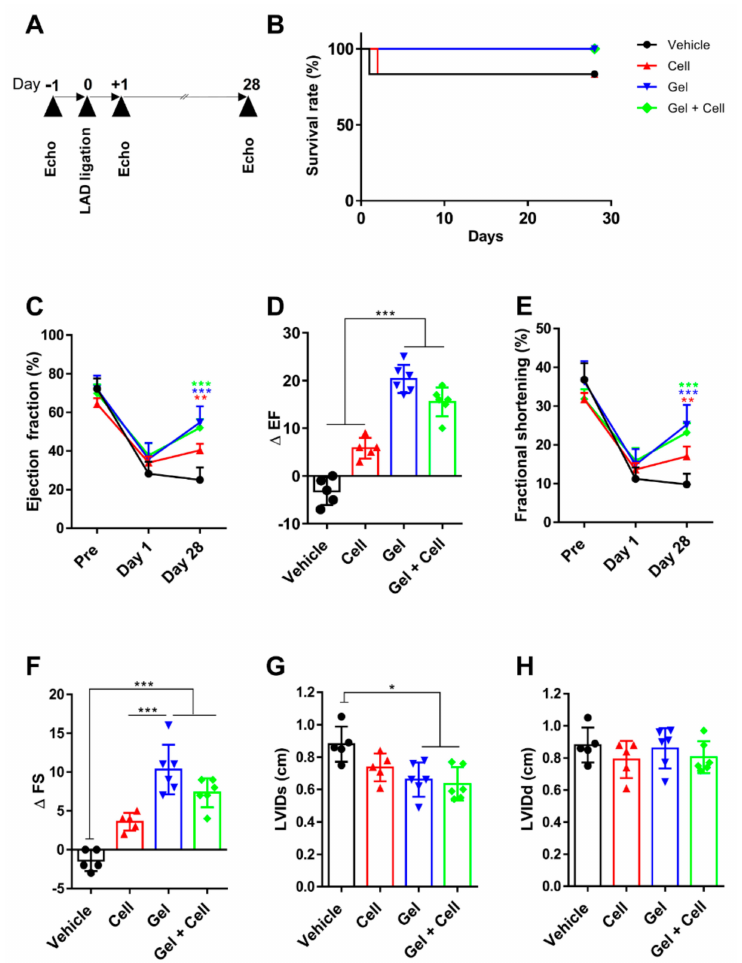
Figure 3. (RADA) 4 -SDKP hydrogel improved cardiac function after myocardial infarction (MI). ( A ) Schematic representation of the in vivo study design. The study animal groups